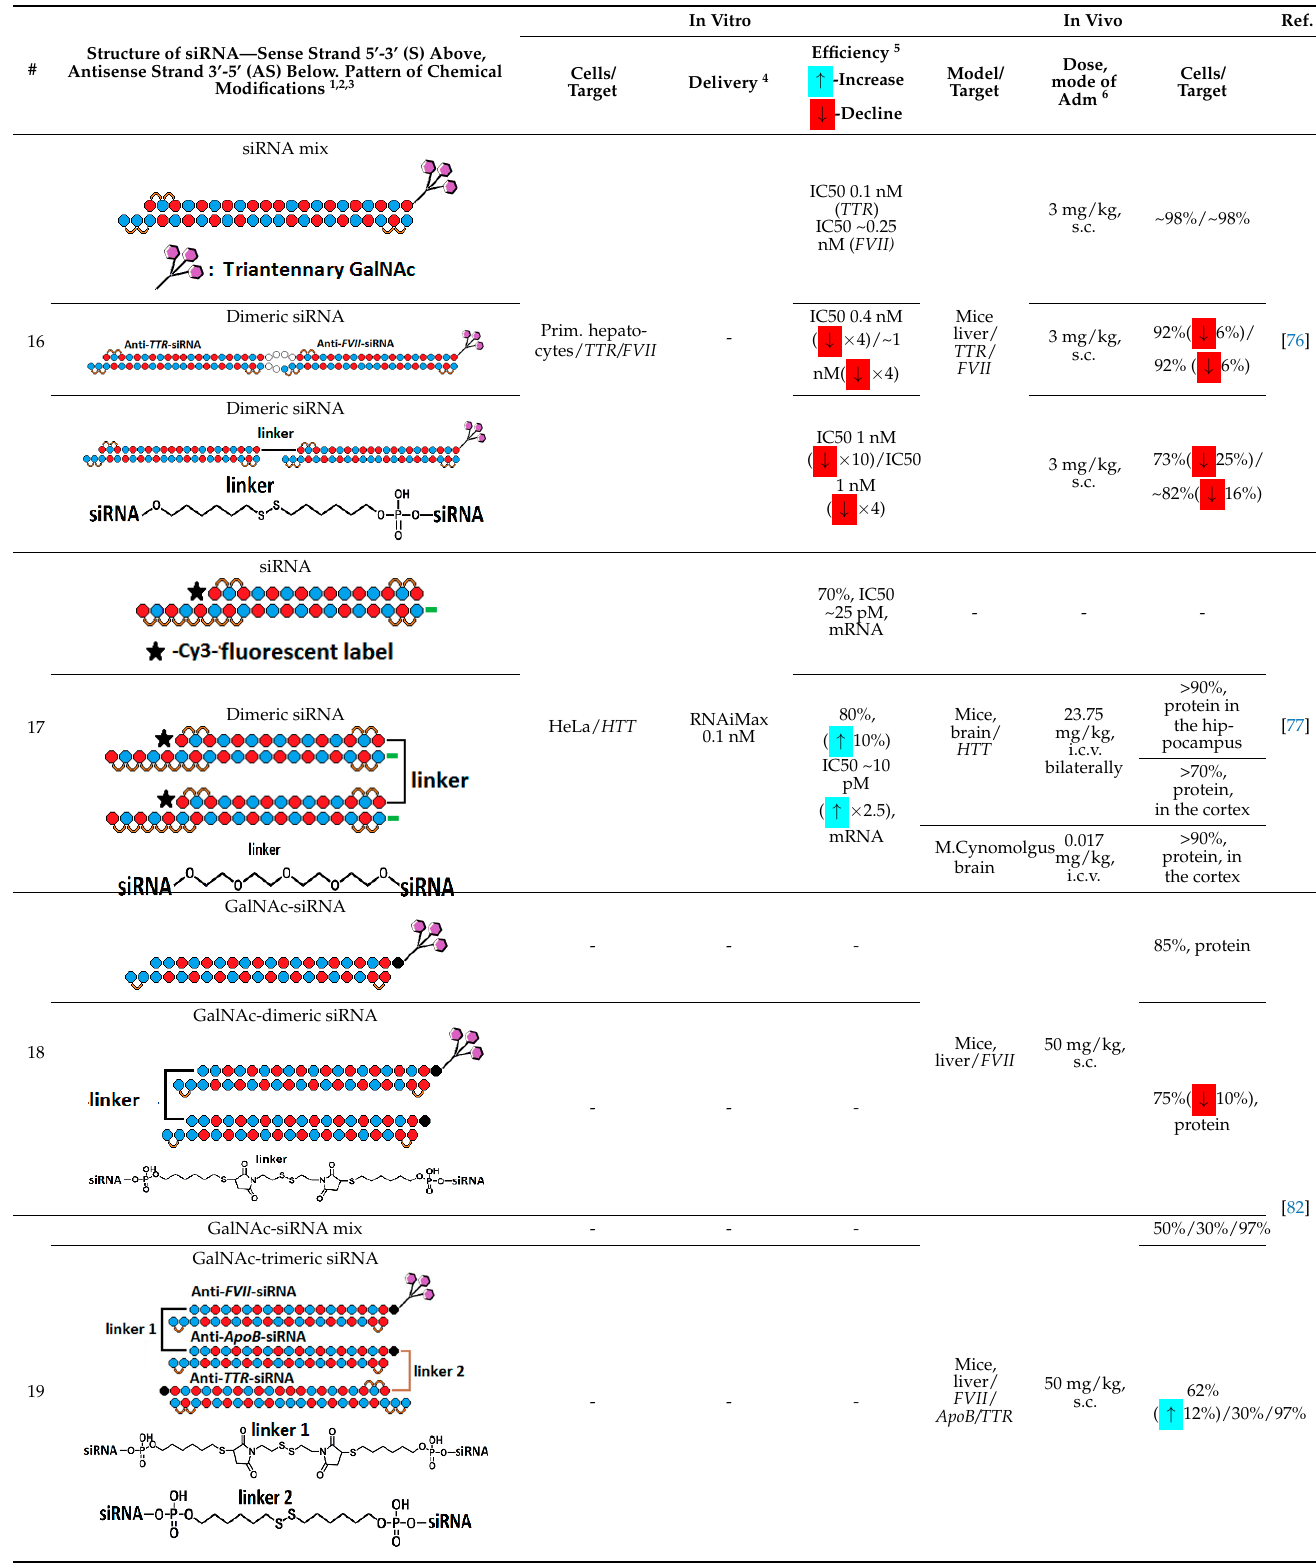
Table 4. Structural modifications of linear multimeric siRNA.